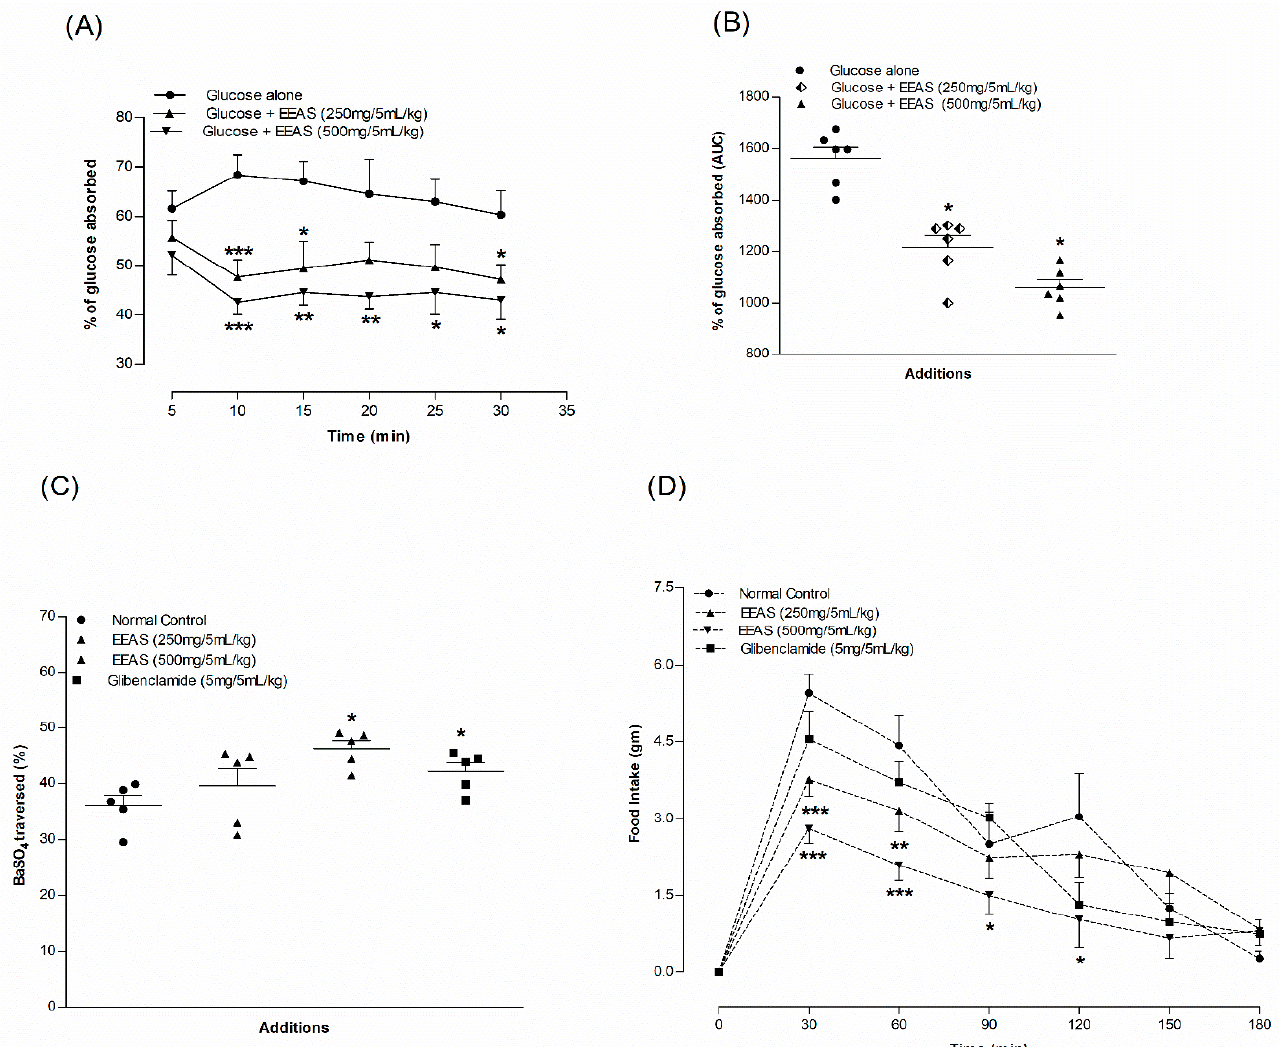
Figure 5. Effects of EEAS on ( A ) intestinal glucose absorption expressed as line graph and ( B ) area under the curve, ( C ) gut motility and ( D ) feeding test. Rats were fasted for 36 h and the intestine was perfused with glucose (54 g/L) with (treated group) or without (control group) ethanol extract of A. squamosa leaves (5 mg/mL and 10 mg/mL; each subject received 15 mL of perfusion). Values n = 6 for gut perfusion and motility and feeding test are mean ± SEM. *, **, *** p < 0.05–0.001 compared to control.